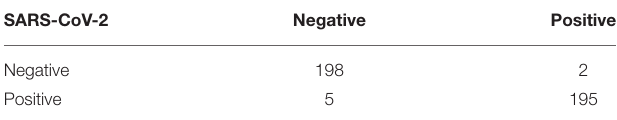
TABLE 2 | Confusion matrix of the proposed network